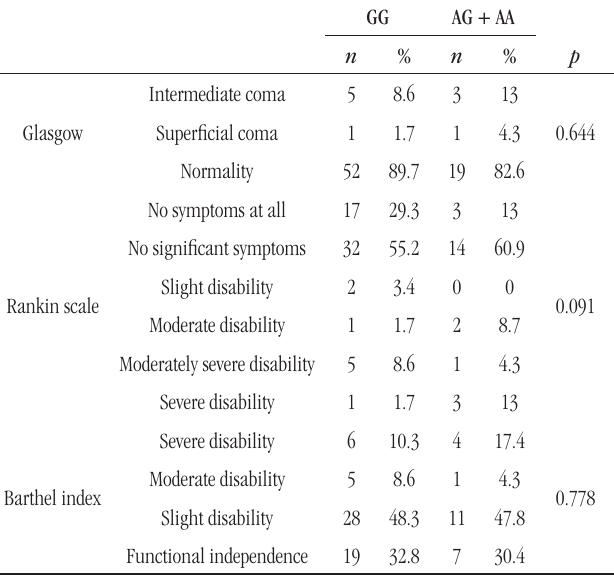
taBLE 4 − Association between TNFA -308G/A (rs1800629) polymorphism genotypes and outcome in case group by Glasgow scale, Rankin scale and Barthel